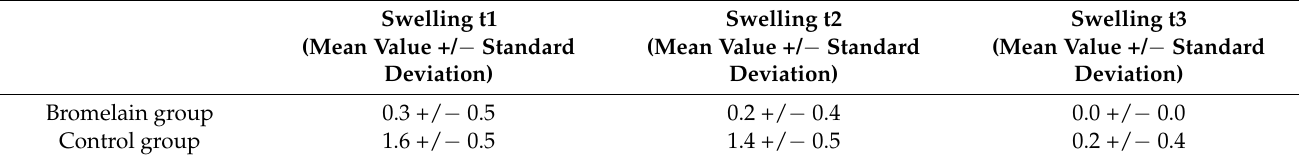
Table 1. VAS score in test group and control group.